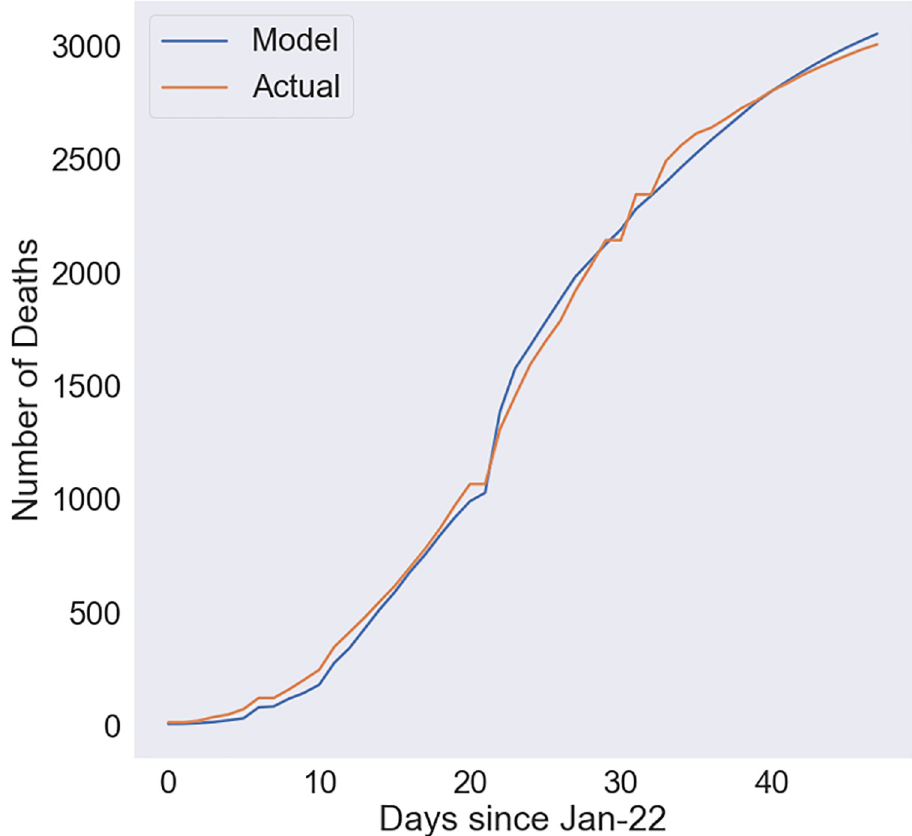
Fig 2. Comparison of modeled and actual number of deaths for the late stage case. Used data from January 22 through March 11.